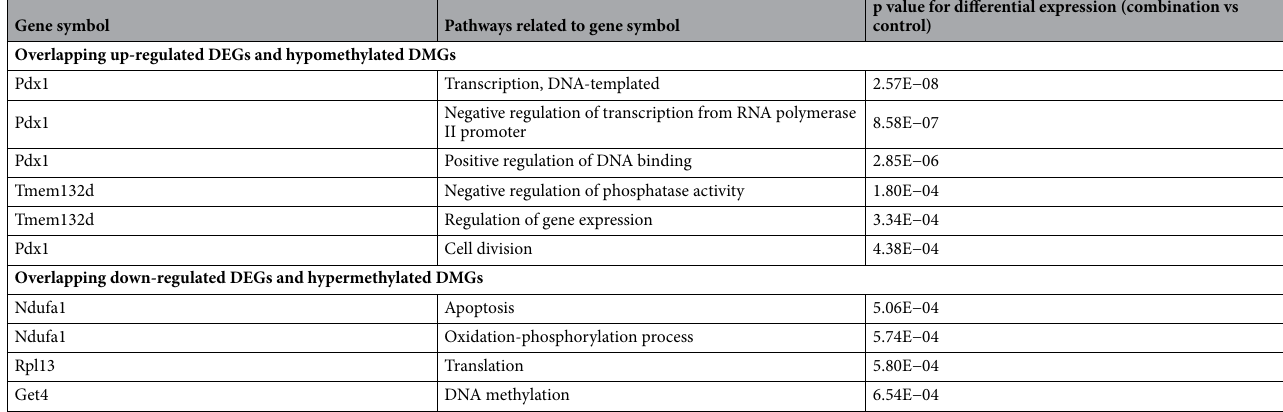
Table 5. Pathway enrichment analyses of overlapped genes between RRBS and RNA-seq data in the combination (BSp + GTPs) treatment